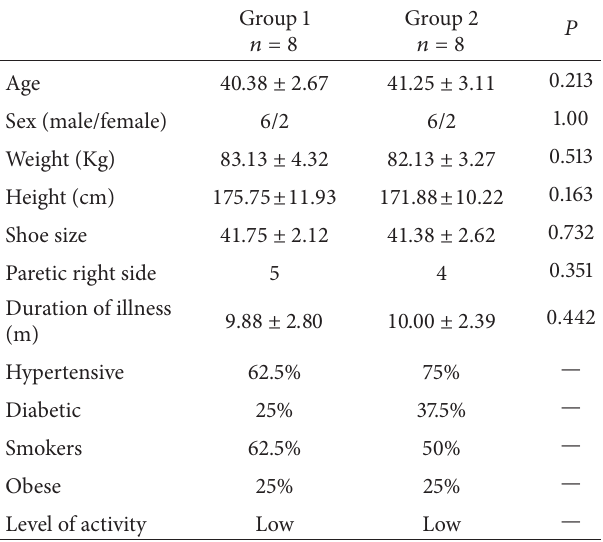
Table 1: Subject characteristics, values presented as mean (SD) and